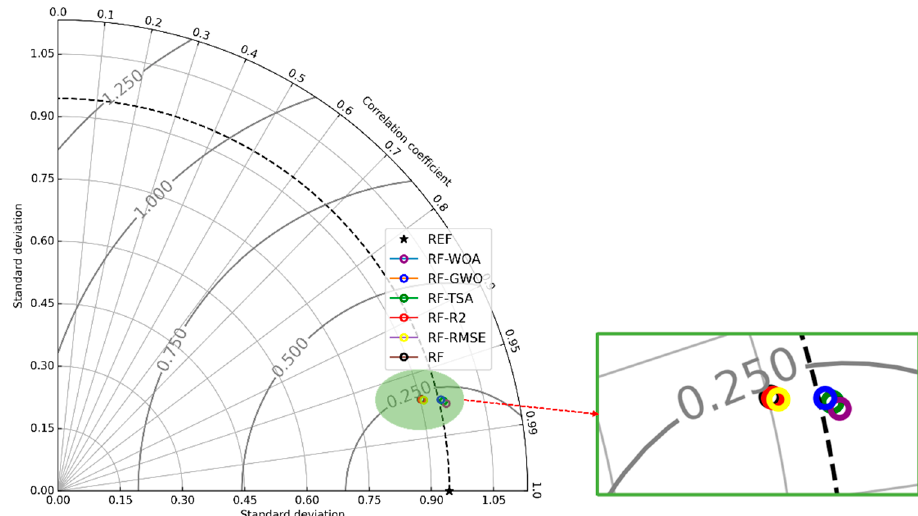
Figure 10. Taylor diagram of the training results for the six developed models.